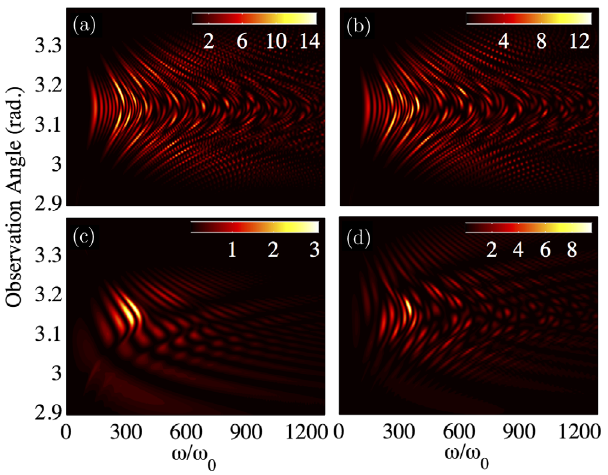
FIG. 13. Emission spectra for an electron of initial γ 0 ¼ 10 in collision with a 10 cycle FWHM laser of peak a 0 ¼ 2 and λ ¼ 0 . 8 μ m. (a) Laser is a plane wave. (b) Laser is modeled as a 5th order paraxial beam focussed to a spot size of w 0 ¼ 0 . 8 μ m ( θ 0 ¼ 1 = π ). (c) a 5th order paraxial beam focussed to a spot size of w 0 ¼ 0 . 2 μ m ( θ 0 ¼ 1 . 2 ). (d) The same as (c) but calculated using the vector beam model.